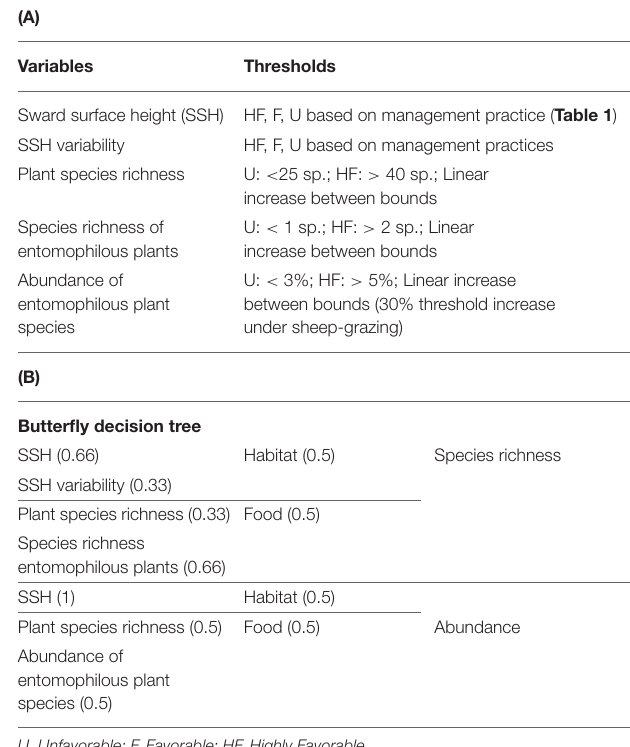
TABLE 2 | Illustration of node calculation for bumblebee species richness (i.e., decision rule result). Species richness of entomophilous plants